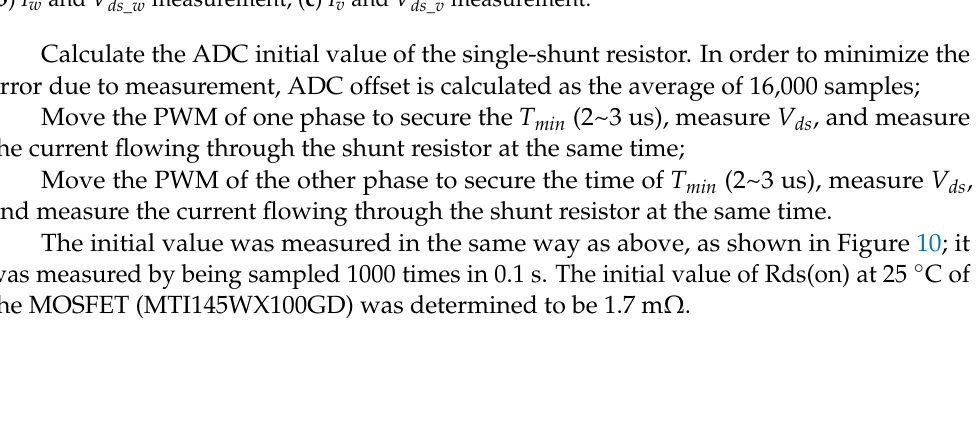
Figure 9. Example of flowchart of system for detecting initial Rds(on); ( a ) ADC offset calculation; ( b ) I w and V ds_w measurement; ( c ) I v and V ds_v measurement.